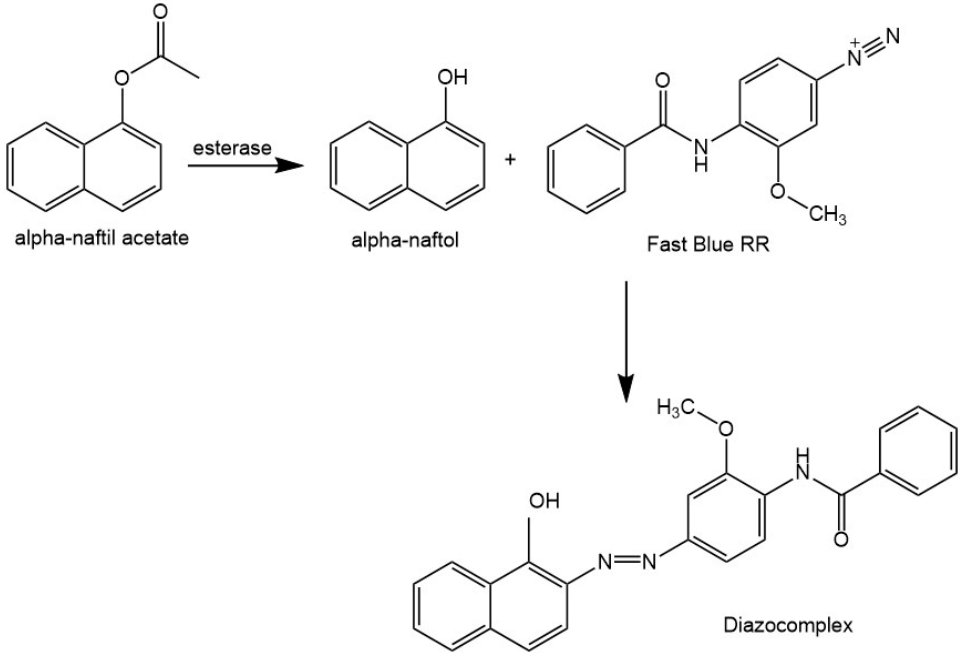
Figure 2. Diazo complex formation by esterase action on alpha-naphthyl acetate. Source: adapted from He [43].